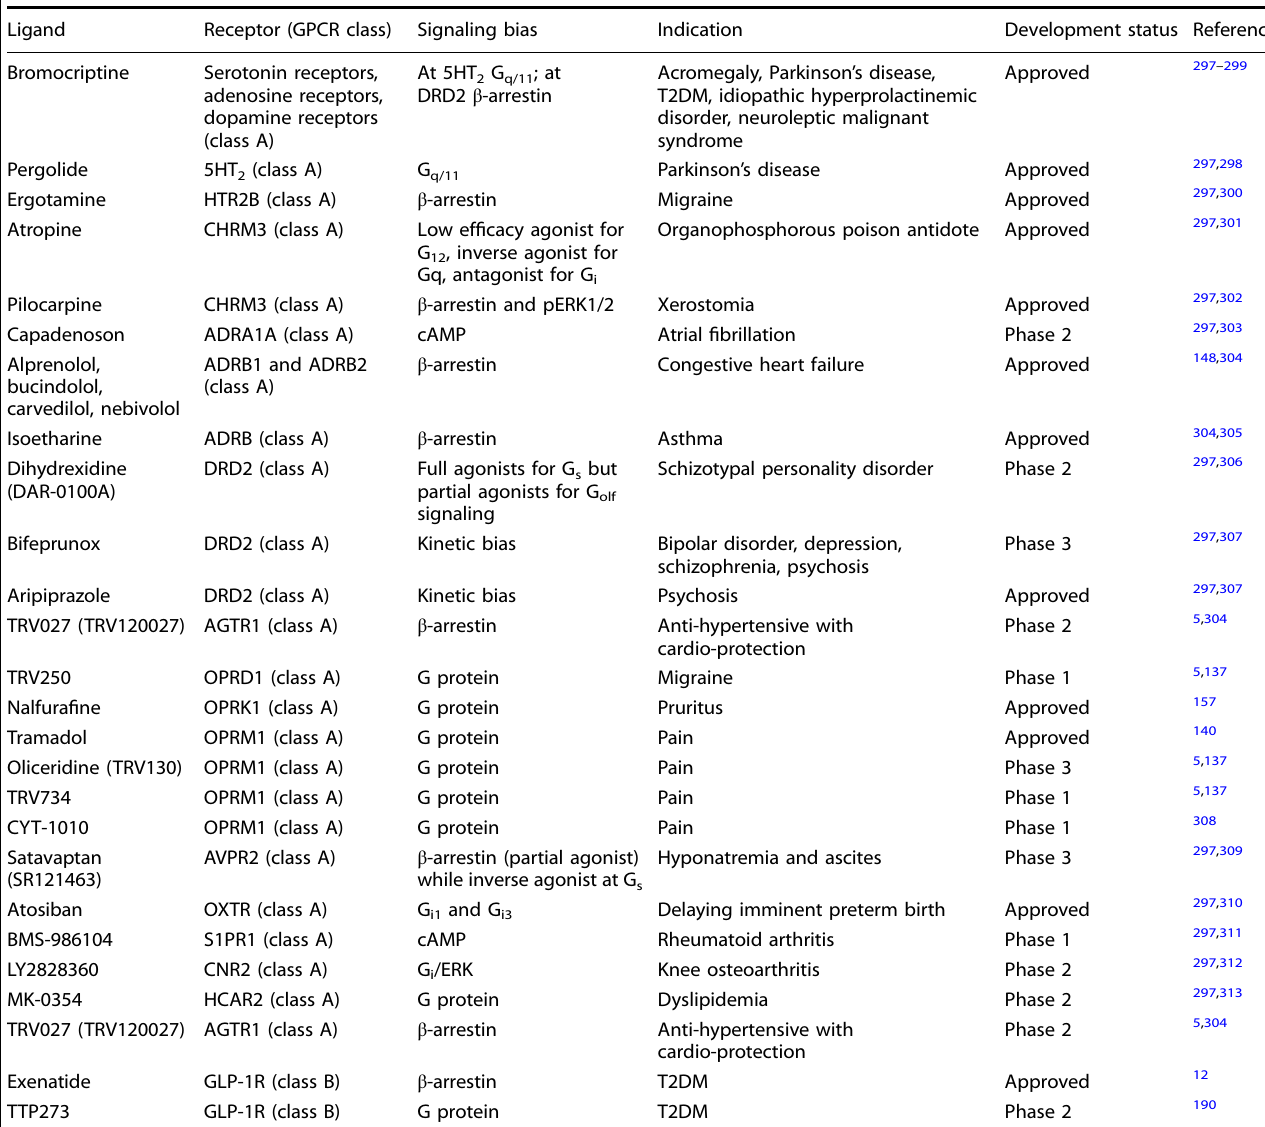
Table 5. Therapeutic agents with biased signaling approved or in clinical